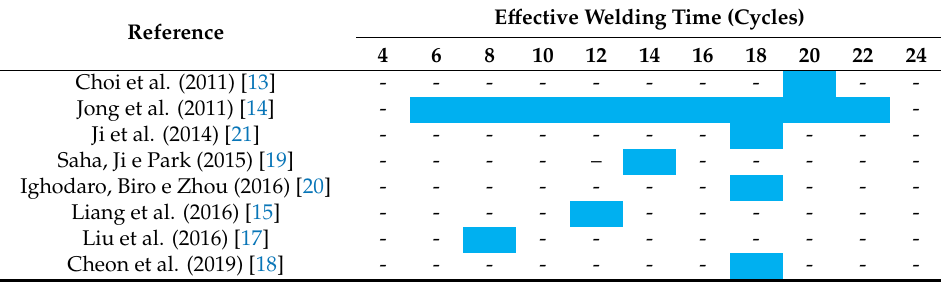
Table 1. Ranges for the e ff ective welding time used in previous researches.